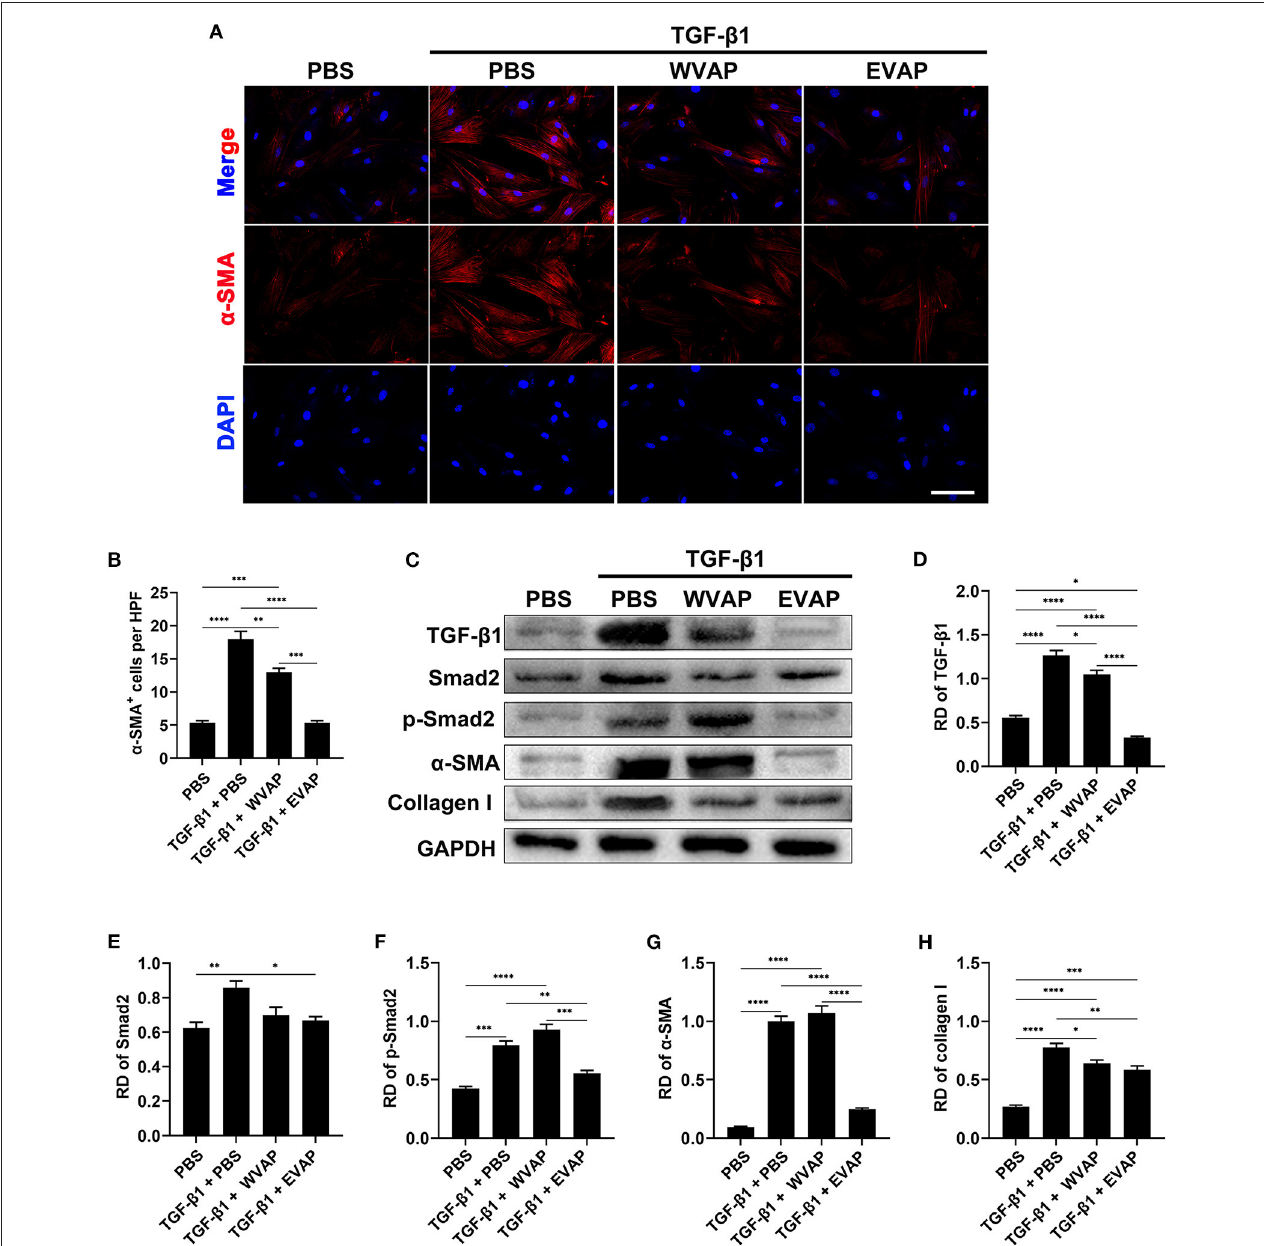
FIGURE 7 | Effects of EVAP on myofibroblast transdifferentiation in the TGF- β 1-induced HDFs. (A) α -SMA staining on the TGF- β 1-induced HDFs (scale bar = 300 µ m). (B) Quantification of α -SMA + cells per HPF. (C) Protein expressions of TGF- β 1, Smad2, p-Smad2 α -SMA and collagen I in the TGF- β 1-induced HDFs. (D–H) RD of WB bands in (B) . Note that EVAP significantly inhibited the TGF- β signaling pathway in vitro . * P < 0.05; ** P < 0.01; *** P < 0.001; mean ± SD; n = 3. HDFs, human dermal fibroblasts; RD, relative